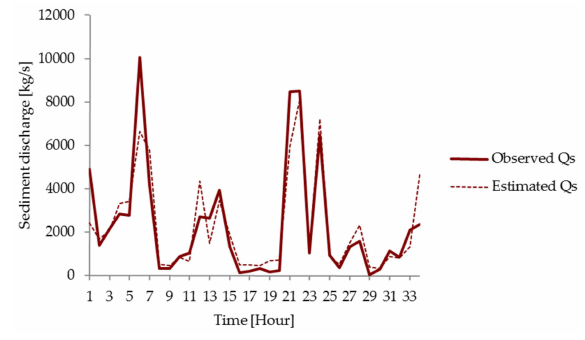
Figure 10. Observed and estimated sediment discharge at cross validation stage using